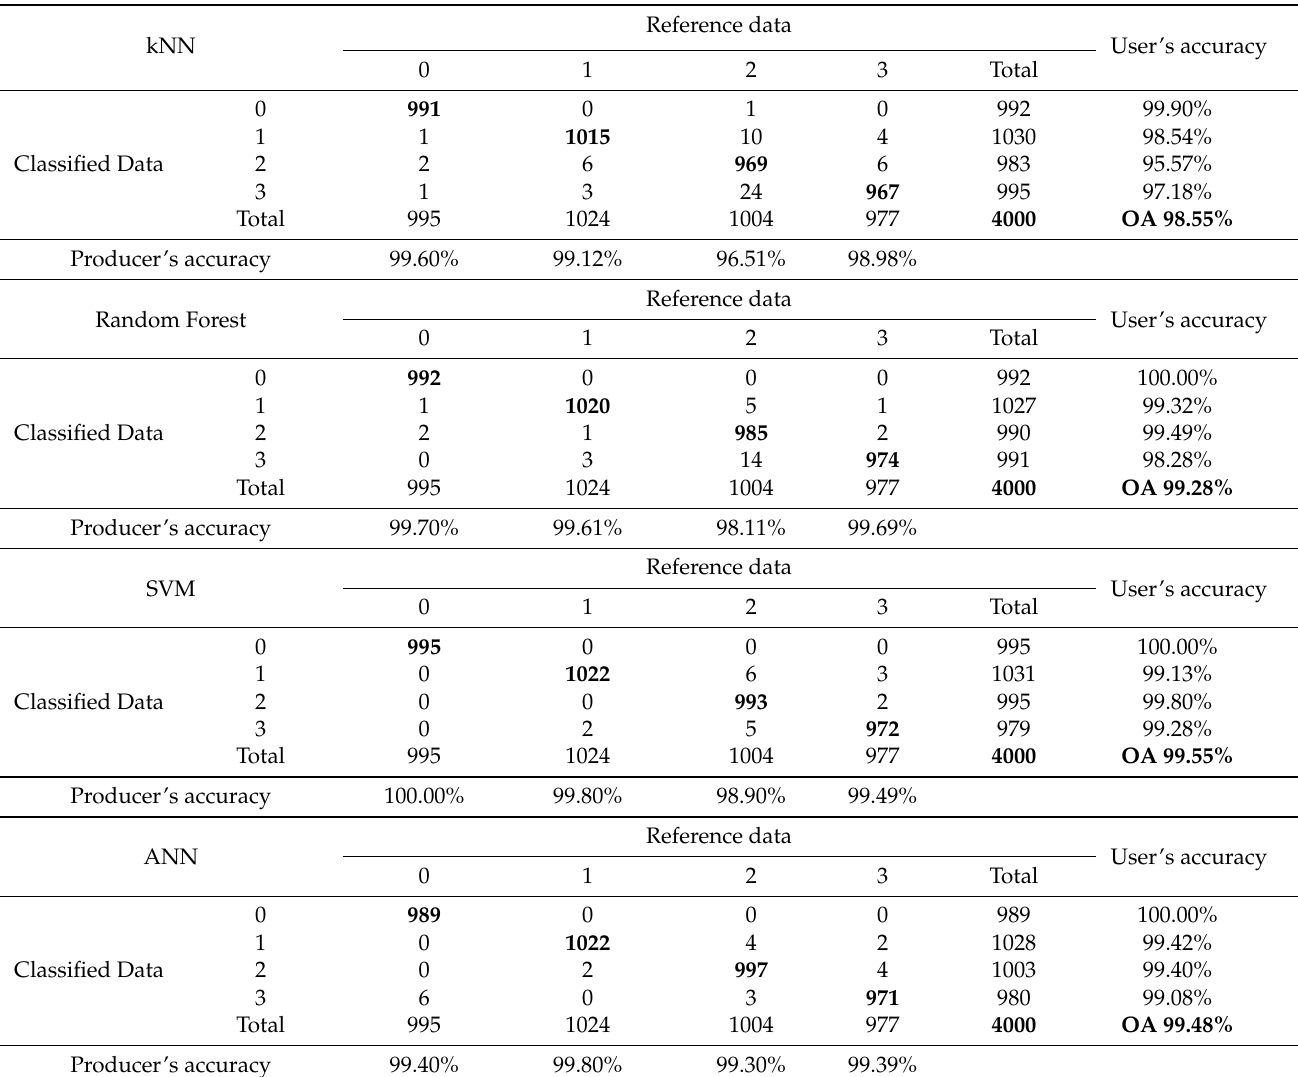
Table 7. Overall accuracy, user’s accuracy, and producer’s accuracy by